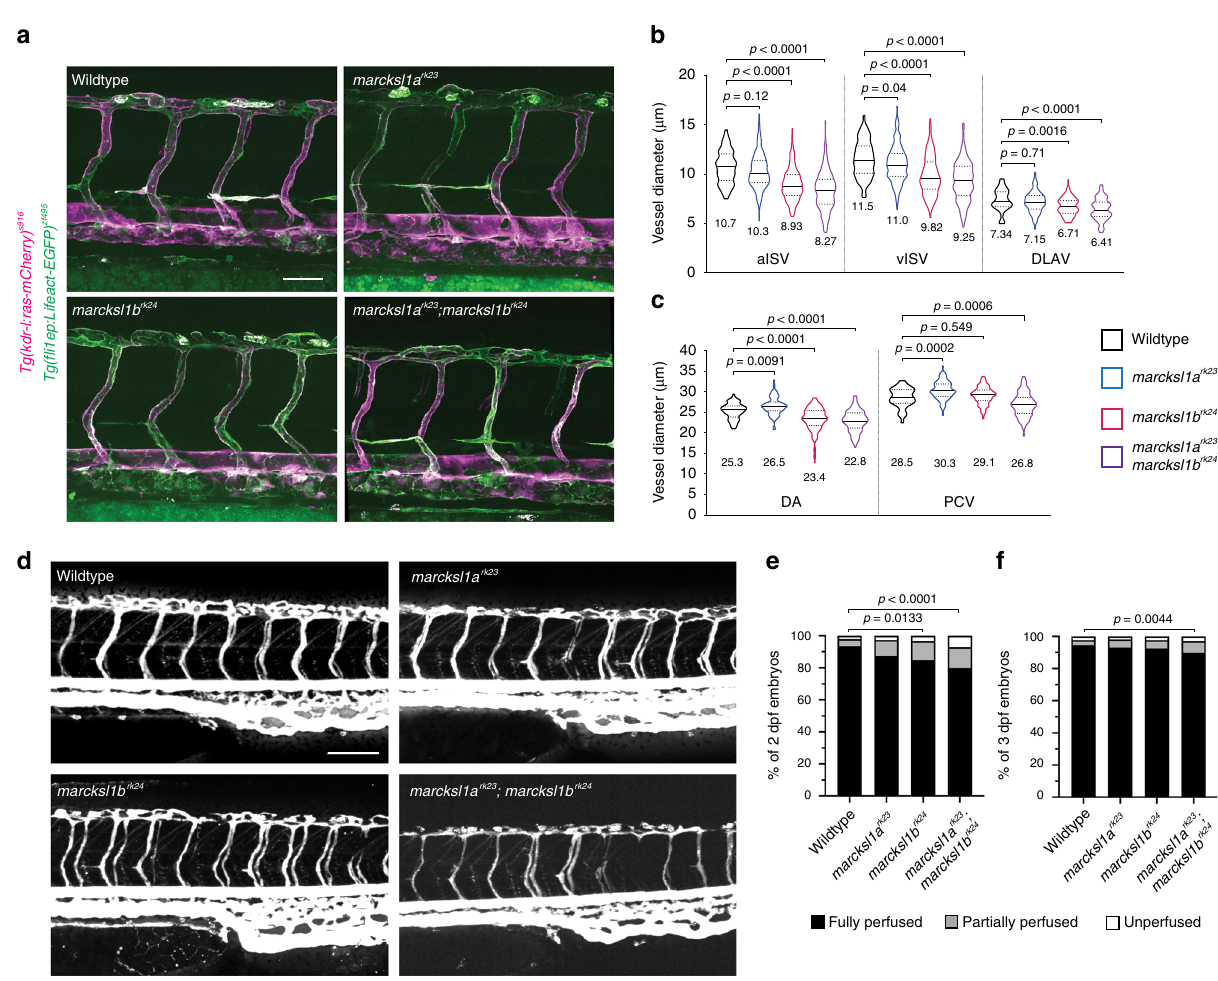
Fig. 3 Depletion of Marcksl1 expression alters vessel diameter and delays lumenisation. a Maximum intensity projection of confocal z-stacks of zebra fi sh trunk vessels of 2 dpf wildtype, marcksl1a rk23 , marcksl1b rk24 and marcksl1a rk23 ;marcksl1b rk24 embryos in Tg( fl i1ep:Lifeact-EGFP) zf495 ;Tg(kdr-l:ras-mCherry) s916 background. b , c Quanti fi cation of aISV, vISV and DLAV ( b ) and DA and PCV ( c ) in wildtype and marcksl1 mutant embryos (wildtype: n = 26 aISVs/27 vISVs from 15 embryos; marcksl1a rk23 : n = 43 aISVs/63 vISVs from 29 embryos; marcksl1b rk24 : n = 79 aISVs/57 vISVs from 39 embryos; marcksl1a rk23 ; marcksl1b rk24 : n = 74 aISVs/46 vISVs from 28 embryos). Data are collected from 2 ( marcksl1a rk23 ;marcksl1b rk24 embryos), 3 ( marcksl1a rk23 and marcksl1b rk24 embryos) and 4 (wildtype embryos) independent experiments. Violin plots represent the entire range of values, dotted lines indicate fi rst and third quartiles, center lines are median. Mean values are indicated. Statistical signi fi cance was determined by ordinary one-way ANOVA with Tukey ’ s multiple comparisons test. d – f Microangiography in wild type and marcksl1 mutant embryos. Images are representative of wildtype, marcksl1a rk23 , marcksl1b rk24 and marcksl1a rk23 ;marcksl1b rk24 embryos at 2 dpf. Quanti fi cation of lumenisation of ISVs in wildtype and marcksl1 mutant embryos at 2 dpf ( e , n = 1472 ISVs from 32 wildtype embryos; n = 1058 ISVs from 23 marcksl1a rk23 embryos; n = 1150 ISVs from 25 marcksl1b rk24 embryos; n = 1564 ISVs from 34 marcksl1a rk23 ; marcksl1b rk24 embryos) and at 3 dpf ( f , n = 1518 ISVs from 33 wildtype embryos; n = 1104 ISVs from 24 marcksl1a rk23 embryos; n = 782 ISVs from 17 marcksl1b rk24 embryos; n = 1748 ISVs from 38 marcksl1a rk23 ;marcksl1b rk24 embryos). ISVs no. 4-26 were analyzed on both sides of the embryo. Data